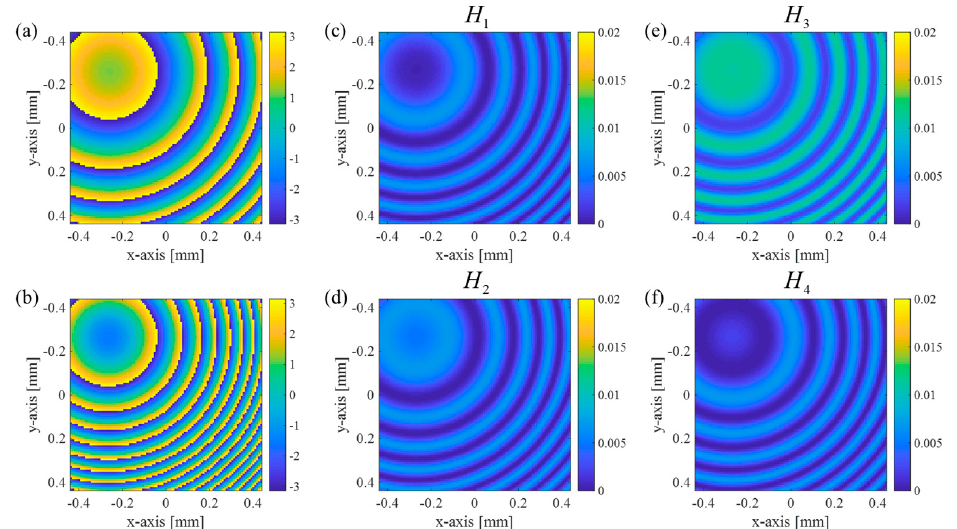
Figure 3. Phase profiles of complex field distributions on the image sensor: ( a ) the modulated wave (GFrT) and ( b ) the non-modulated wave (FrT). Phase shifted intensity profiles ( c ) H 1 , ( d ) H 2 , ( e ) H 3 , and ( f ) H 4 with phase-shifted values 0, π /2, π ,3 π /2 simulated on the image sensor with micro-polarizer array. The point object is located at 30 mm depth and the system parameters are d 1 = 70 mm, d 2 = 10 mm, and f = 100